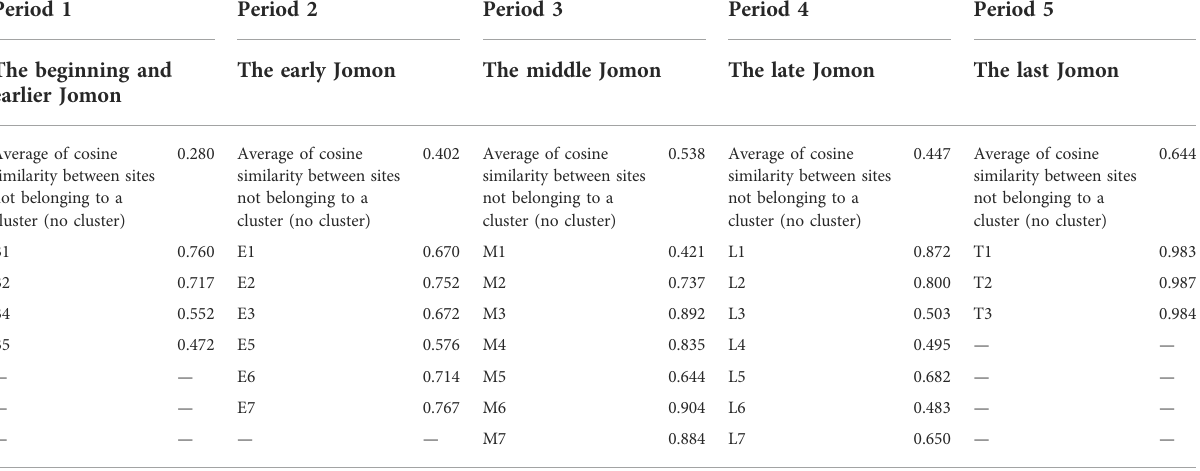
TABLE 1 Cosine similarity within each cluster and between sites not belonging to a cluster in each period category.